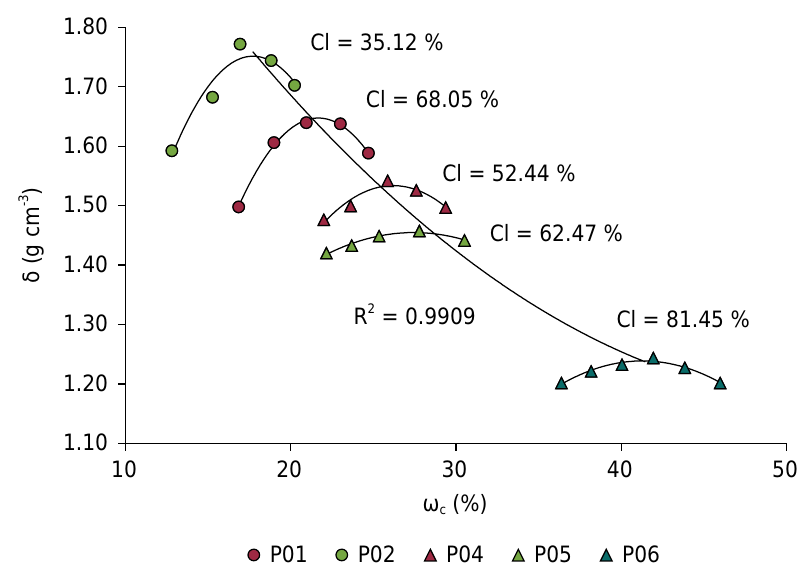
Figure 6. Quadratic adjustment of maximum points in the Proctor compaction curves (δ: apparent specific mass of dry soil; ѡ c : gravimetric moisture; Cl: clay